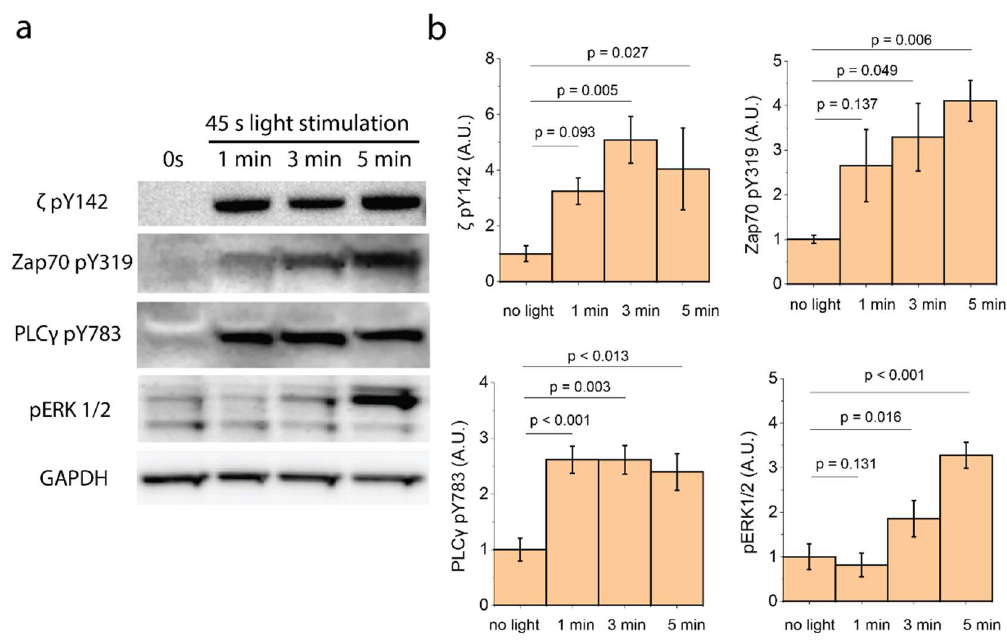
Figure 3. Western blot of T cell receptor (TCR) proximal signaling molecules in LIC-Z-transfected Jurkat 76 cell line. Western blot images ( a ) and quantification ( b ) of Jurkat 76 cell line transfected with LIC-Z and treated, or not, with blue light for 45 s followed by incubation in the dark for indicated time period (minutes). GAPDH was used as a loading control. Data are from ≥ 3 biological replicates. One-way ANOVA with Fisher LSD post hoc test.